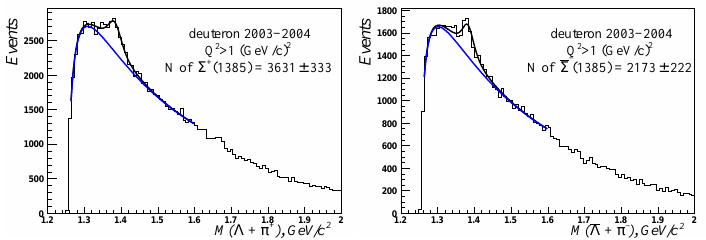
Fig. 1. Invariant mass distributions of Λπ + (left) and ¯ Λπ − (right) in the primary vertex.